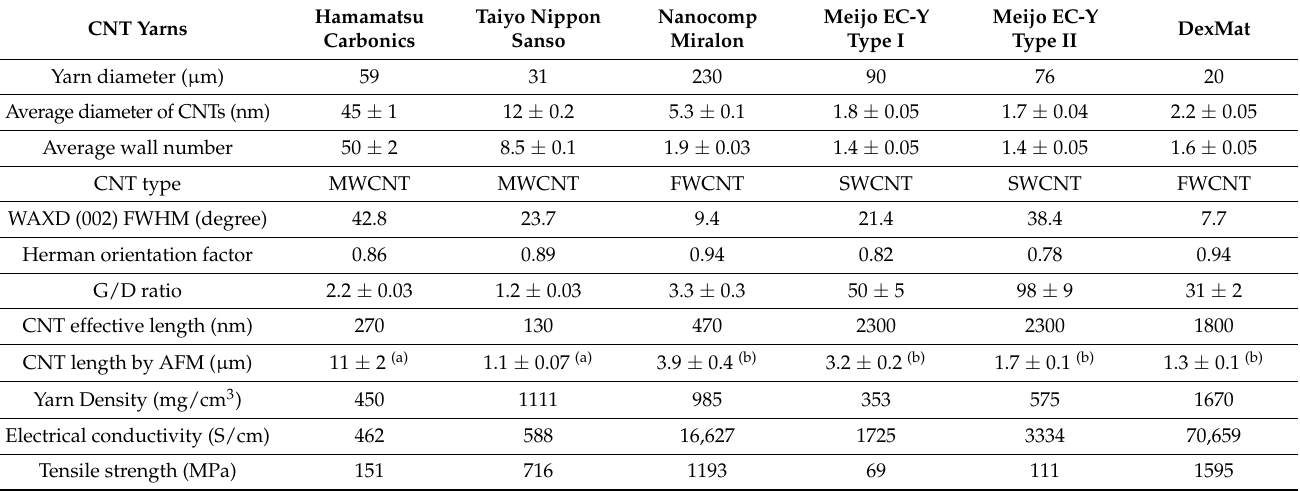
Figure 2. Cross-sectional SEM images of CNT yarns. ( a ) Low-magnification images. ( b ) High- magnification images. Table 1. Physical properties of the CNT yarns in this